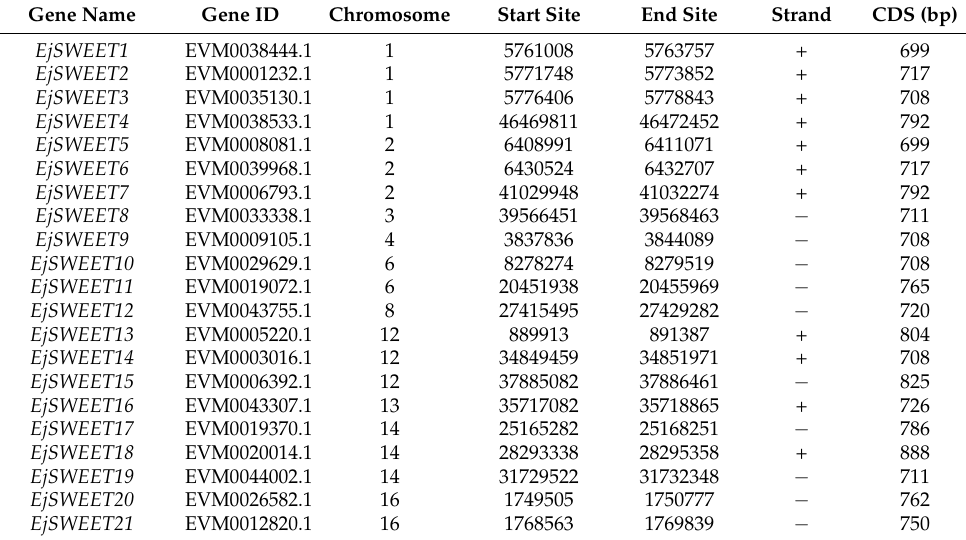
Table 2. The basic information about SWEET genes in loquat.